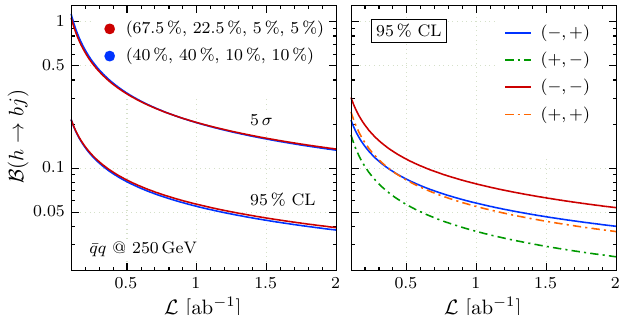
( h bj ) in the hadronic B !